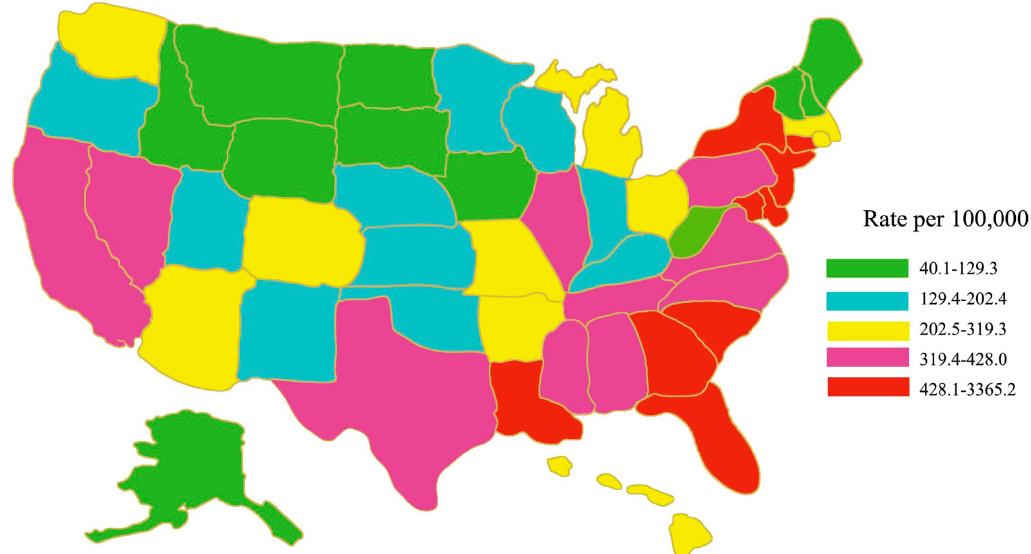
Figure 1. Rates of persons aged 18–64 years living with a diagnosis of HIV infection, year-end 2008—United States. Adapted from [12].